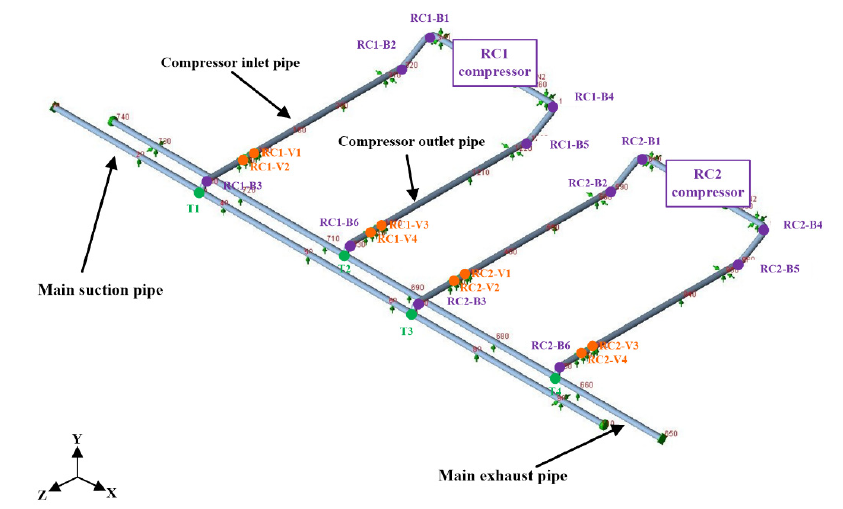
Figure 9. The model of overall piping system.